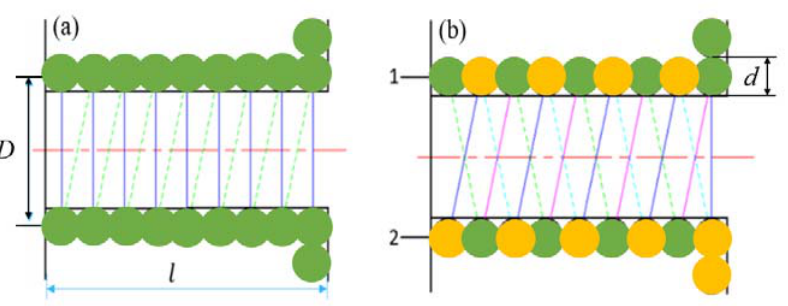
Figure 2. Winding principle of parallel coil: ( a ) coil of single wire, ( b ) parallel interleaved closely wound coil.